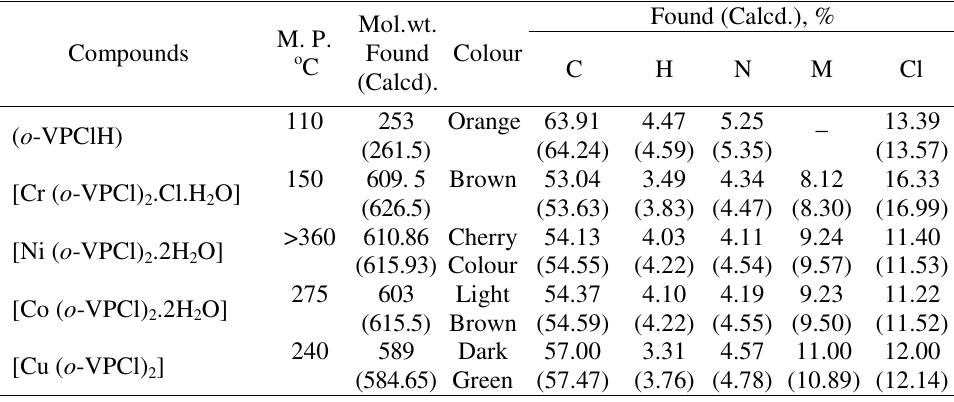
Table 3 . Physical and analytical data of the ligand & its complexes synthesized by microwave